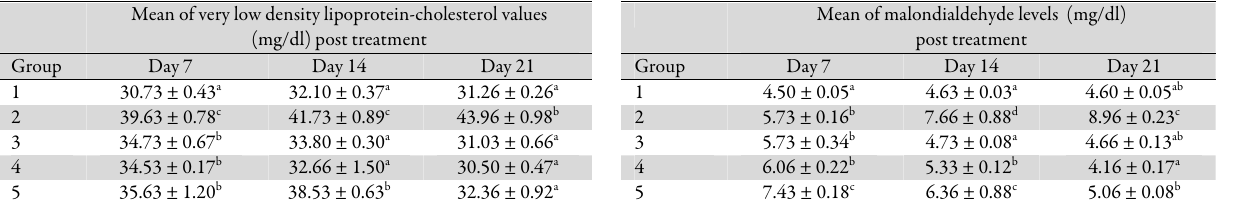
Different superscript along the same column (across groups) indicate significant difference at p < 0.0 Table 8. The mean of malondialdehyde values of alloxan induced diabetic rats treated with combinations of glibenclamide and aqueous extract of G. latifolium